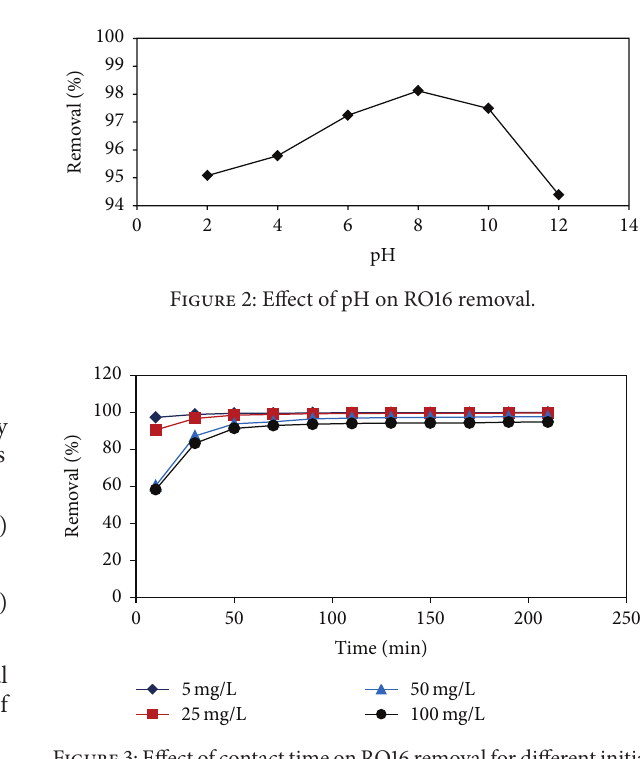
Figure 3: Effect of contact time on RO16 removal for different initial dye